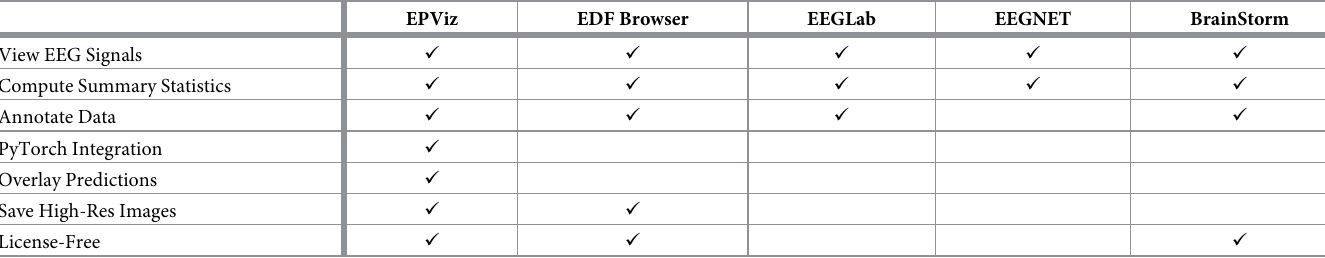
Table 2. Summary of features provided by EPViz, as compared to existing EEG